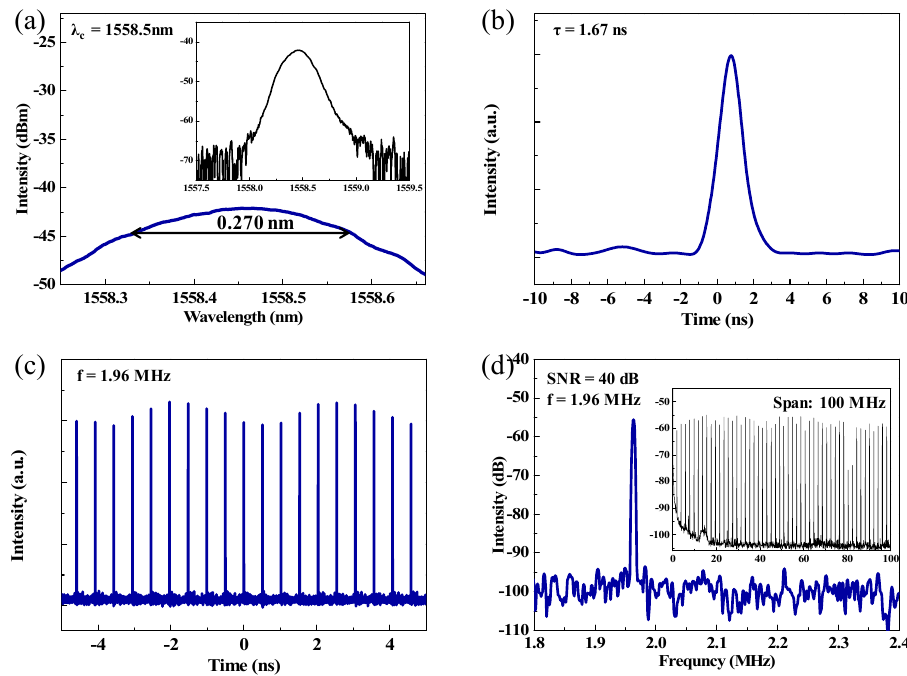
Figure 5. ( a ) The output optical spectrum, ( b ) a zoom in single-pulse profile, ( c ) the pulse train, and ( d ) RF spectrum (inset, spectrum measured in 100 MHz range).